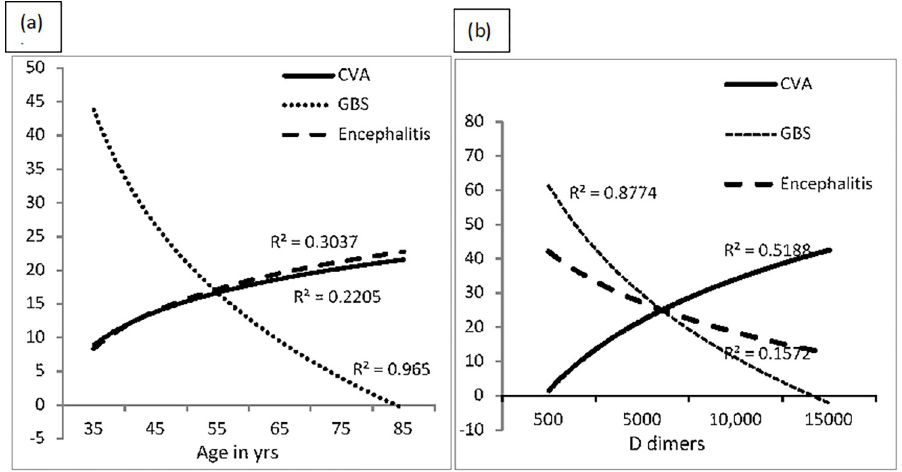
Fig 2. Correlation between age in yrs. and D-dimer levels with different types of neurological manifestations. CVA (Cerebrovascular Events), GBS (Guillen Barre Syndrome). (a) Shows patients with GBS were from young age group, there was decline in cases with increase in age, and Cerebrovascular Events were more from old age group and same with encephalitis. (b) Shows relationship between D-dimers and neurological manifestation, patients with GBS had negative correlation with D-dimers whereas patients with CVA had positive correlation elaborated as R 2